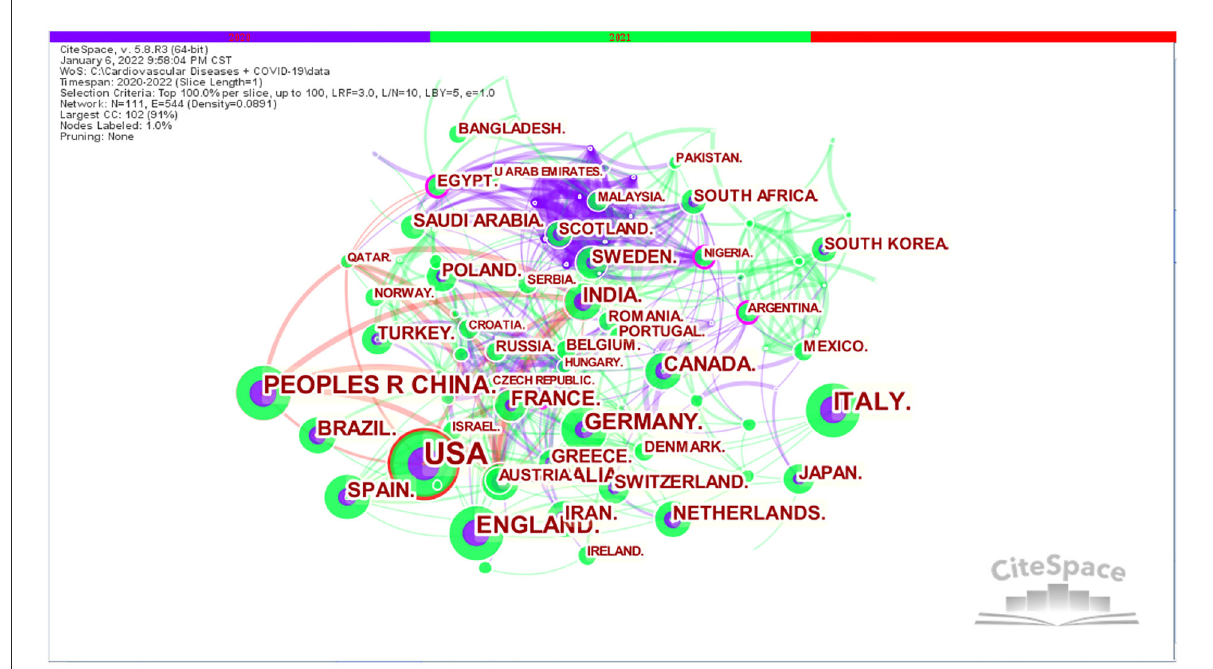
FIGURE2 Visualization map of countries/regions in the studies of CVDs and COVID-19 research.